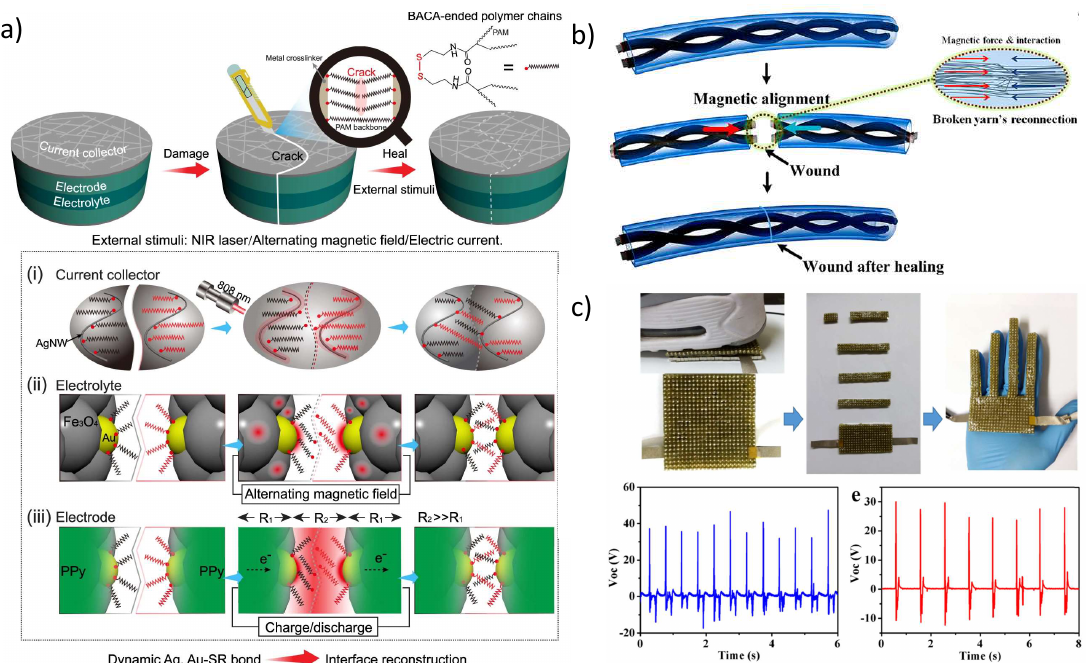
Figure 9. ( a ) A schematic representation of the interface reconstruction process of a magnetic self- healing supercapacitor induced by NIR irradiation [130]. ( b ) The healing of a yarn-based self-healing supercapacitor with excellent reconnectivity promoted by magnetic interactions. Adapted with permission from [131]. Copyright 2015, American Chemical Society. ( c ) An artificial skin based on a triboelectric nanogenerator, showing excellent conductive property recovery when the material is submitted to catastrophic damage. Adapted with permission from [133]. Copyright 2017,